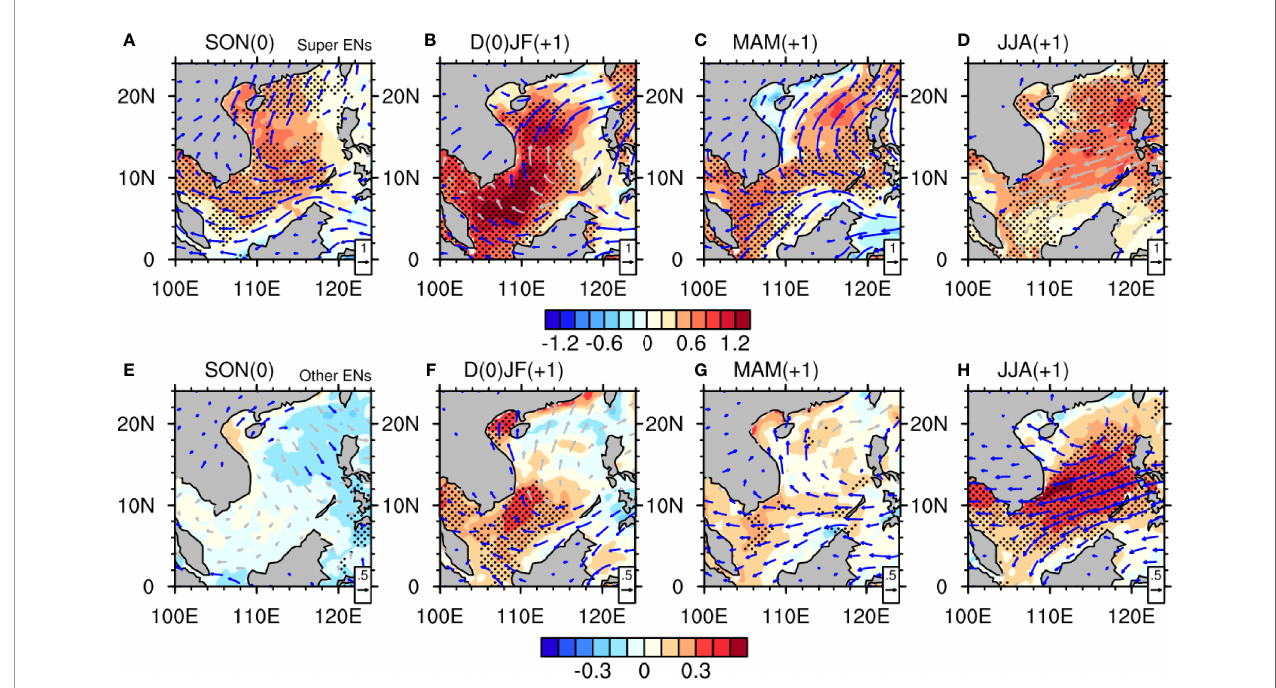
FIGURE 3 | Composited SST anomalies (shading; unit: °C) and 975-hPa wind anomalies (vector; unit: m/s) during (A) SON(0), (B) D(0)JF(+1), (C) MAM(+1), and (D) JJA(+1) for super El Niño events. (E – H) Same as in (A – D) but for other El Niño events composite. The black dots and blue vectors indicate the composite exceeding the 90% signi fi cance level based on Student ’ s t